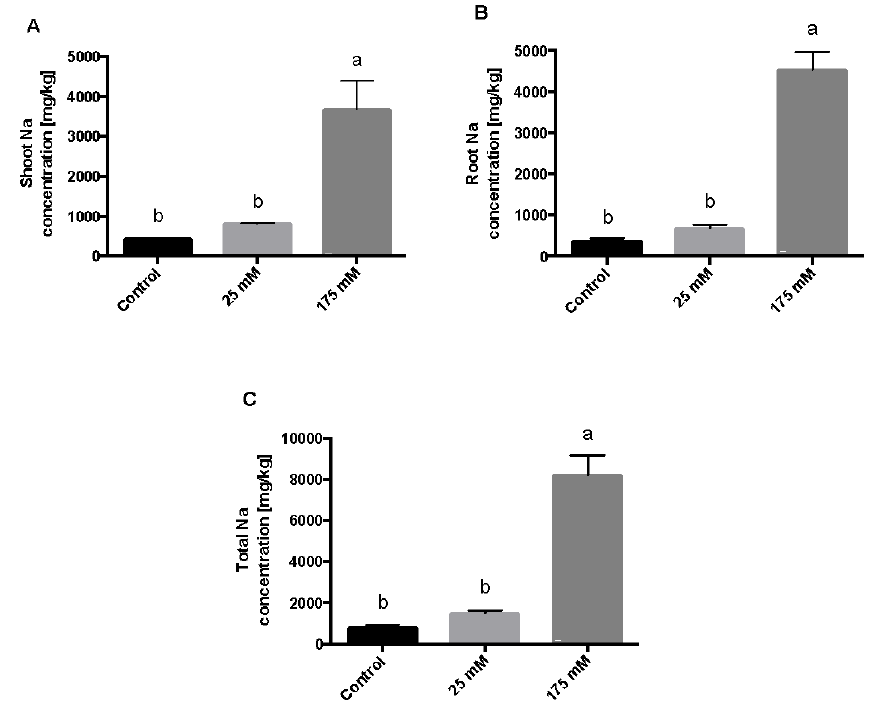
Figure 4. Na concentration in S. lycopersicum plants after low and high salt treatments. S. lycopersicum seedlings were treated with low and high concentrations of NaCl as well as controls (0, 25, and 175 mM). After 10 days of NaCl treatment, Na concentration was measured in the shoot ( A ), root ( B ), and total Na concentration ( C ). The letters a and b represent statistically significant differences with p < 0.05. Error bars represent the standard error of the mean.